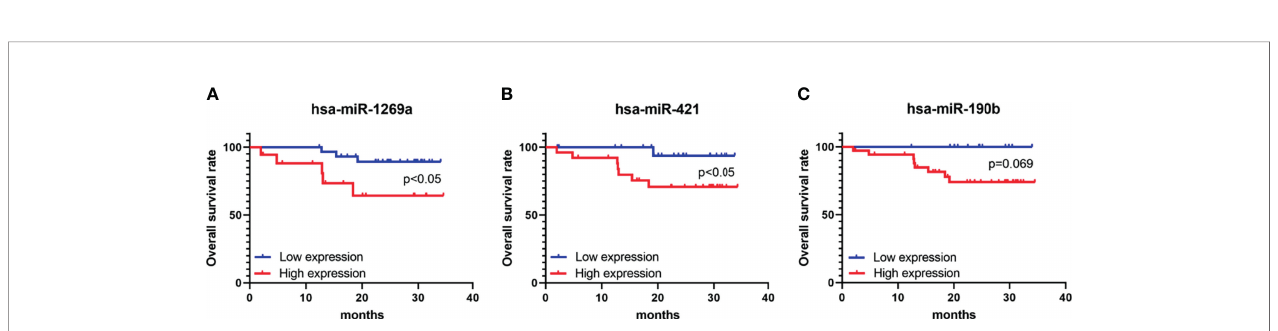
FIGURE 8 | K-M survival analysis of overall survival (OS) of hsa-miR-1269a, hsa-miR-421, and hsa-miR-190b in clinical samples. (A) Correlation of hsa-miR-1269a with OS ( p < 0.05) (B) Correlation of hsa-miR-421 with OS ( p < 0.05) (C) Correlation of hsa-miR-4326 with